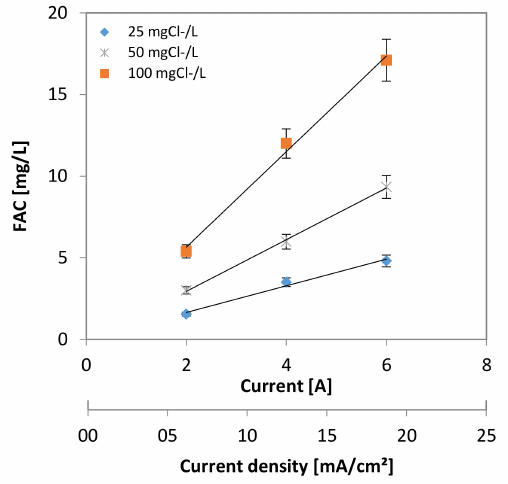
Figure 4. Relation between current and FAC concentration ( n = 9) (Q = 75 L / h, EC = 400 µ S / cm, T = 19 ± 1 ◦